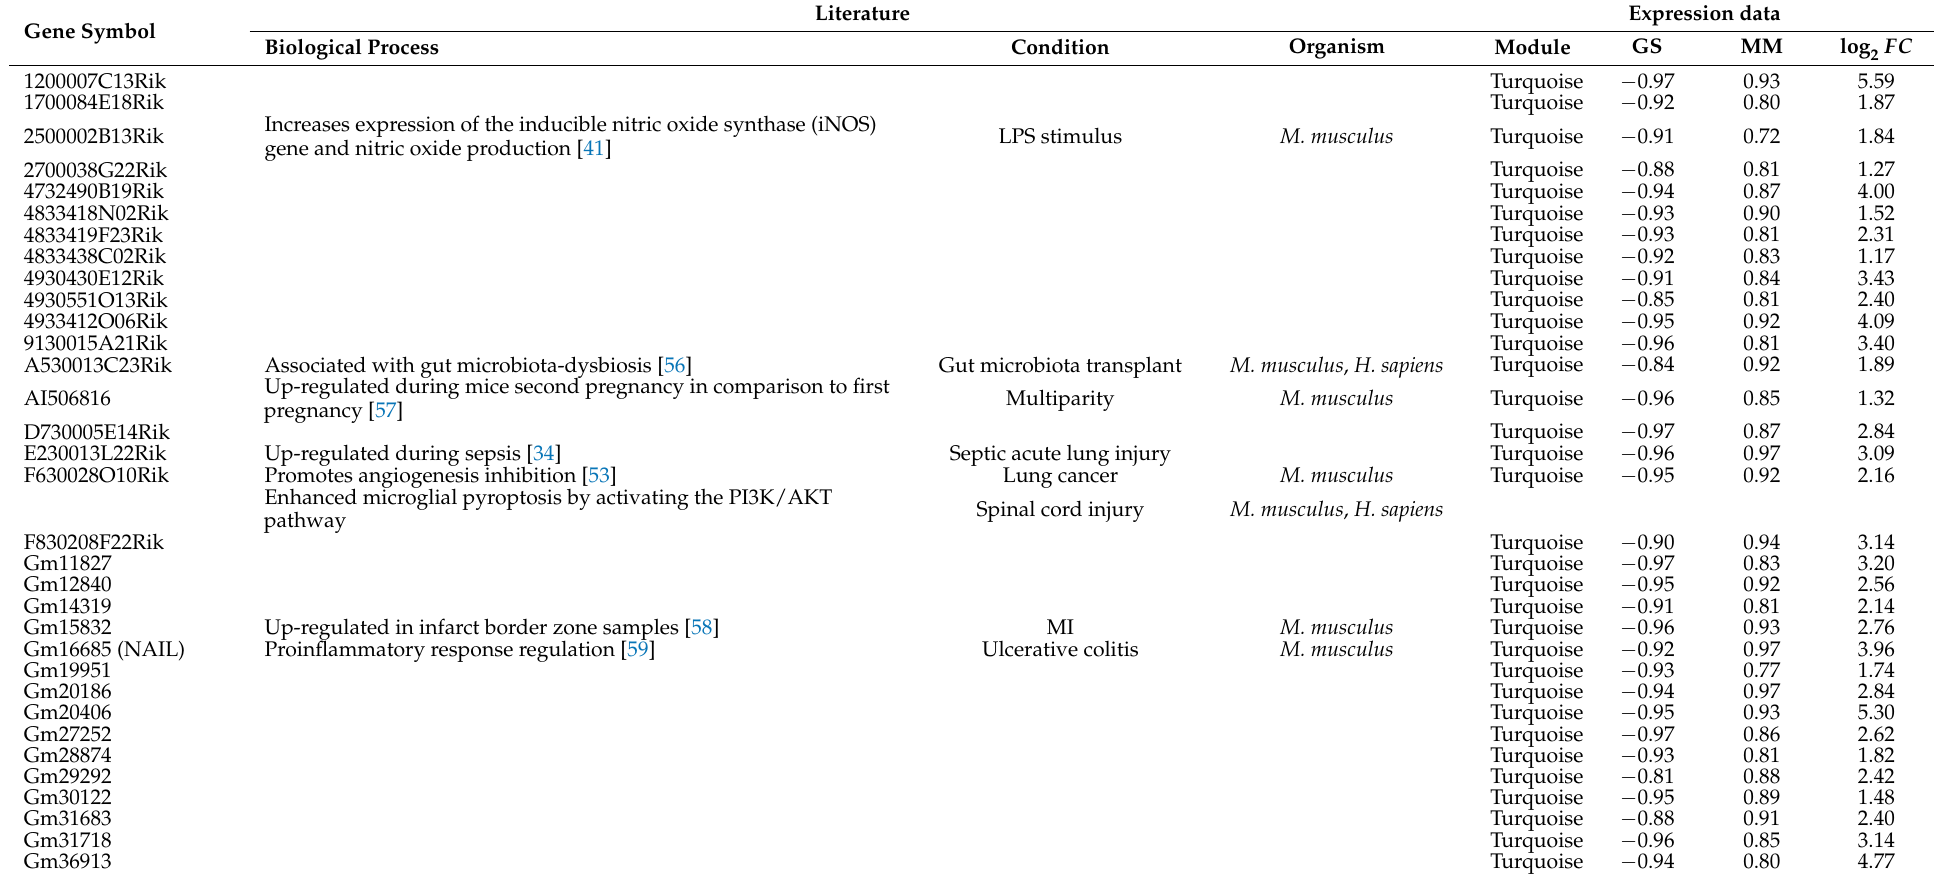
Table 1. Information regarding the lncRNA reported in the literature, as well as the module, gene significance (GS), module membership (MM), and log FC ) from all selected lncRNA. Myocardial infarction: MI; lipopolysaccharide, (log 2